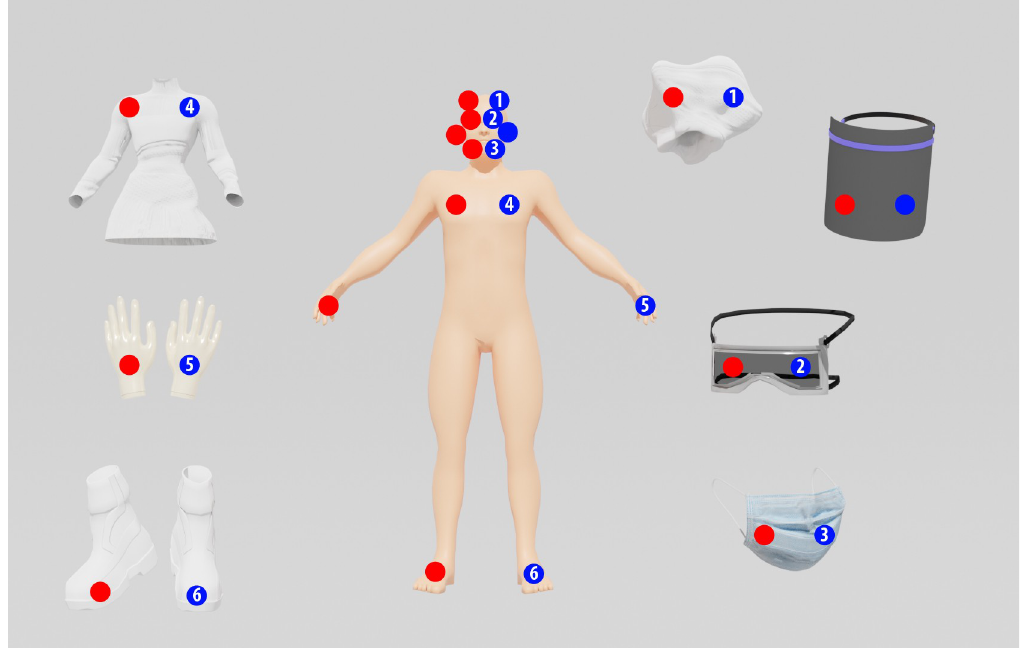
Fig 2. Demarcated areas for contamination by the test microorganisms for evaluation of the potential of instantaneous disinfection by the spray biocidal agent (0.25% sodium hypochlorite). The red circles represent the inoculation area (30 cm 2 ) used as control (right side), the blue circles represent the inoculation area (30 cm 2 ) used as test (left side), and the numbers in the blue circles represent the positions of the water-sensitive papers for each experiment: (1) cap; (2) safety glasses; (3) respirator face mask; (4) lab coat; (5) glove; and (6) shoe. For the control, the surface of the items was swabbed for microorganism collection immediately after surface contamination, while for the tests, the surfaces were swabbed after predetermined exposure times to the biocidal